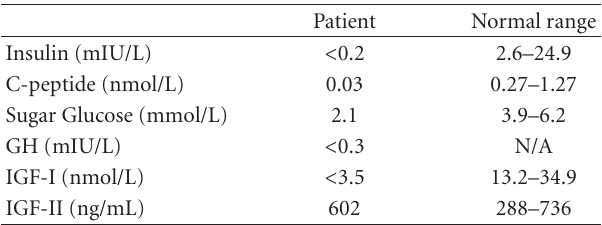
Table 1: Serum levels of the patient when presented with hypo-